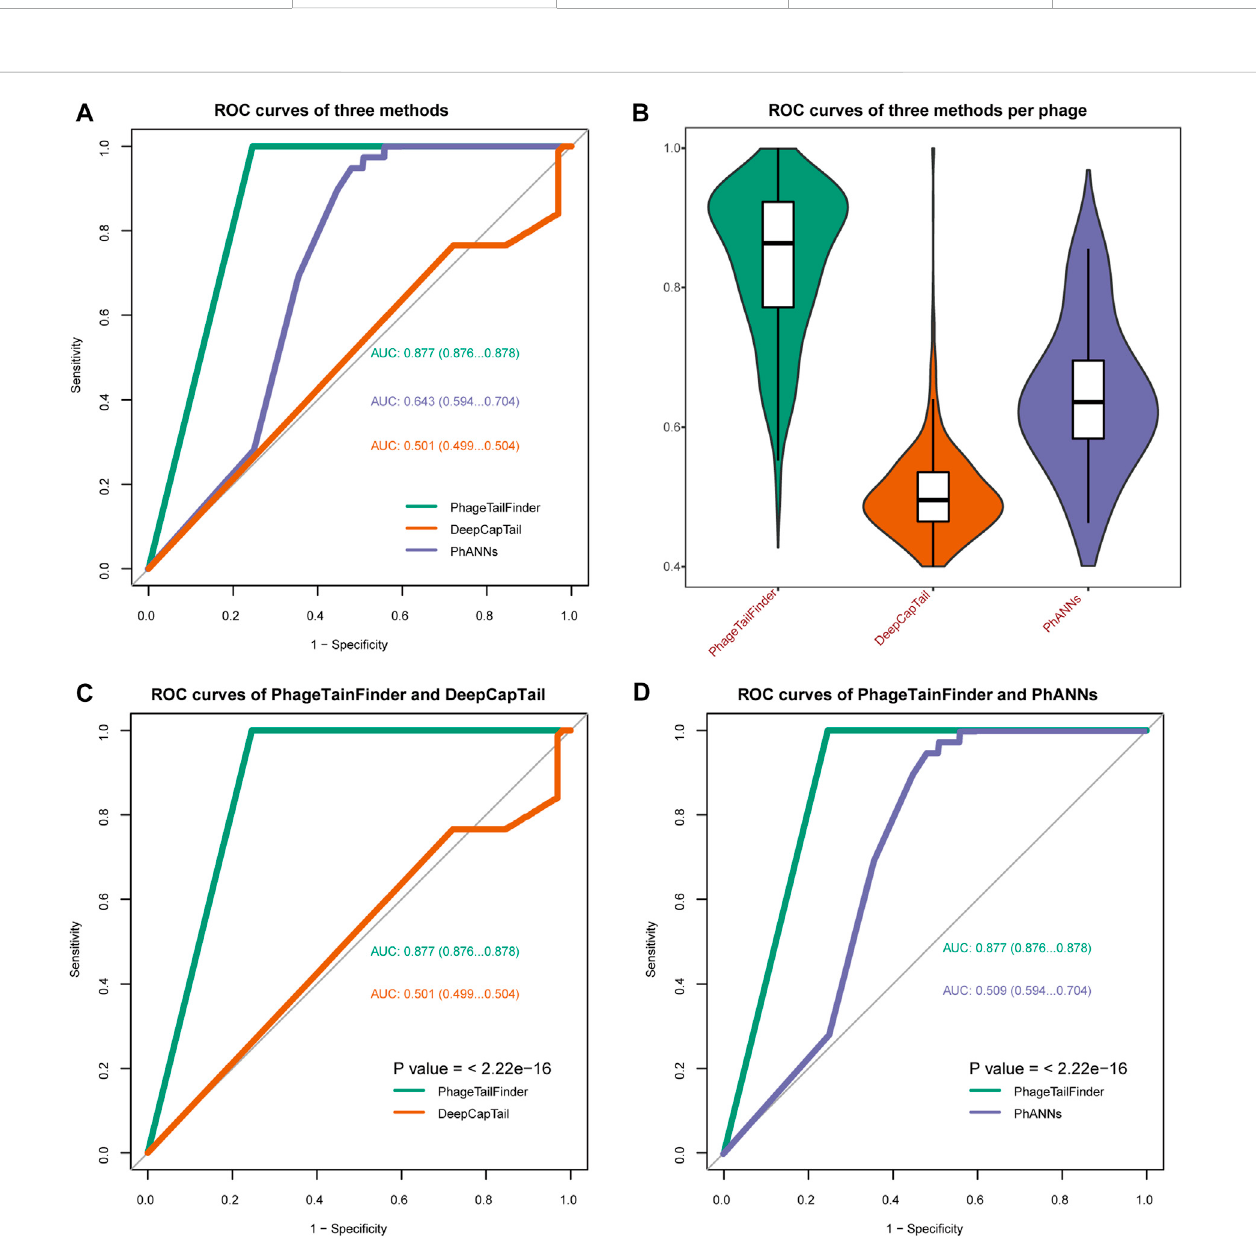
FIGURE 4 ComparisonsoftheperformanceofthePhageTailFinderwithVIRALpro, DeepCapTail,andPhANNs. (A) ROC curveshowingthepredictivepower offour tools when analyzing a test set consisting of 992 complete phage genomes. The resulting AUC values were 0.877, 0.643, and 0.501. (B) . Distribution of the AUC values per phage using four tools. (C) Bootstrap test on ROC between PhageTailFinder and DeepCapTail. (D) Bootstrap test on ROC between PhageTailFinder and